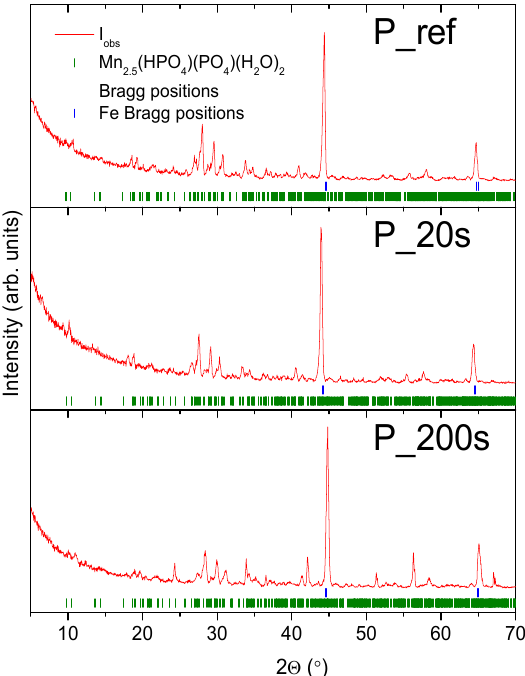
Figure 17. XRD patterns for the P_Ref, P_20s, and P_200s samples. Solid red lines are measured patterns, the green tickmarks correspond to Mn 2.5 (HPO 4 )(PO 4 )(H 2 O) 2 phase, and the blue tickmarks correspond to iron. Table 11. The values of corrosion potential, current density, and corrosion rate estimated for samples chemically treated in passivation conditions.